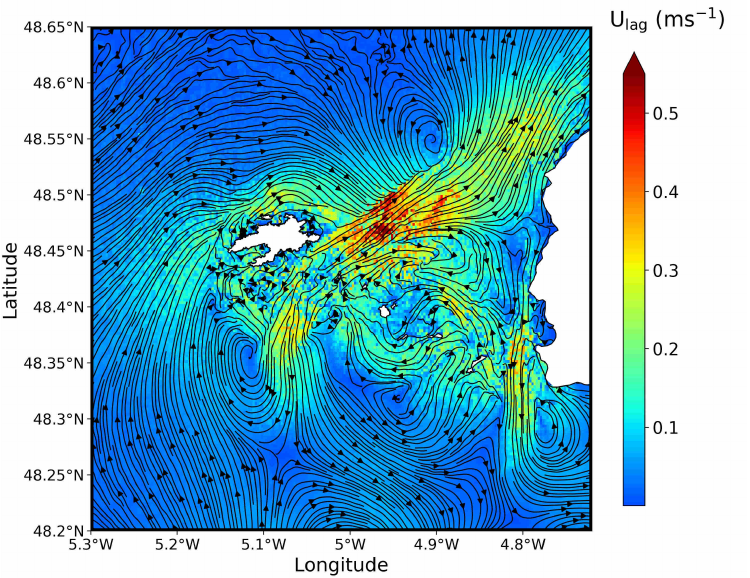
Figure 9. Streamlines from M 2 tidal residual Lagrangian currents within the Ushant-Molène archipelago (adapted from